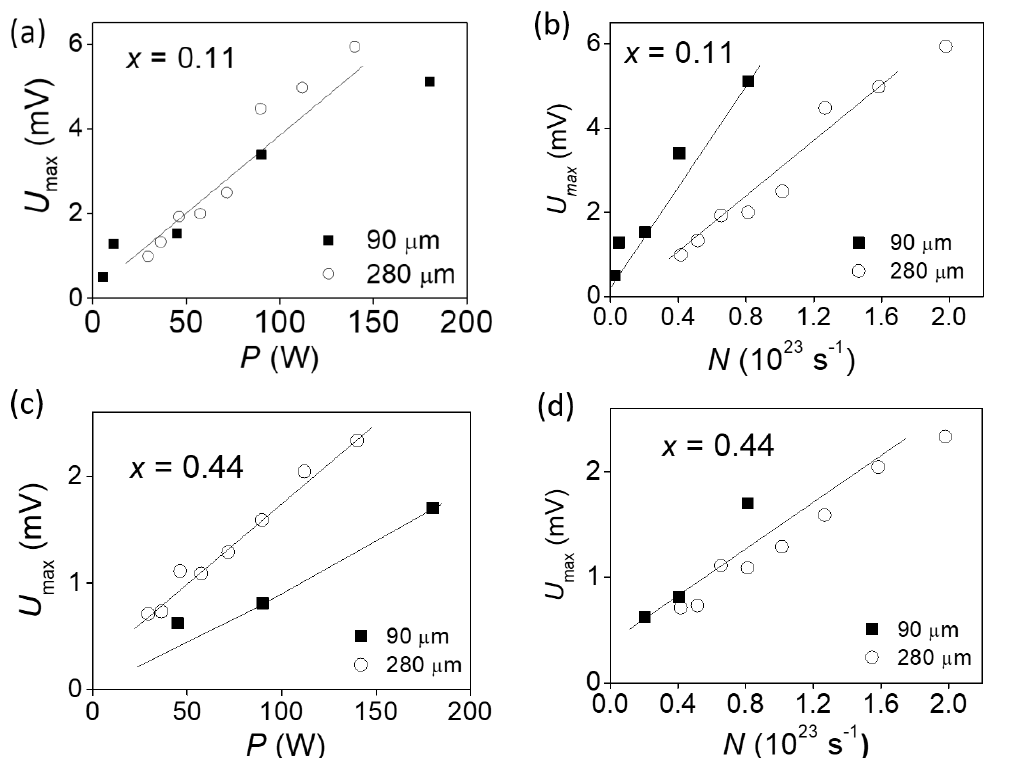
Figure 3. Dependence of the PEM effect amplitude on the radiation power ( a , c ) and incident quanta flux ( b , d ) for the trivial phase sample with x = 0.11 ( a , b ) and for the topological phase sample with x = 0.44 ( c , d ). Open symbols—radiation wavelength 280 μm, full symbols—90 μm. B = 0.44 T ( a , b ) and 3.7 T ( c , d ), T = 4.2 K.